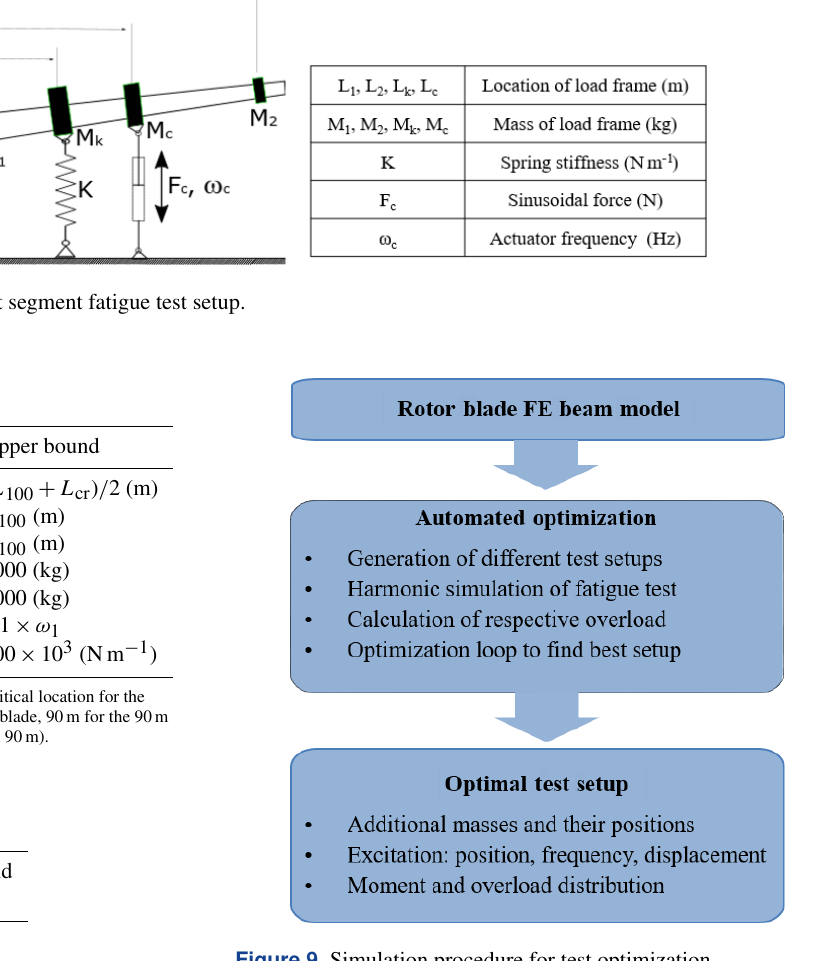
Figure 9. Simulation procedure for test optimization. Table 4. Optimization parameters in